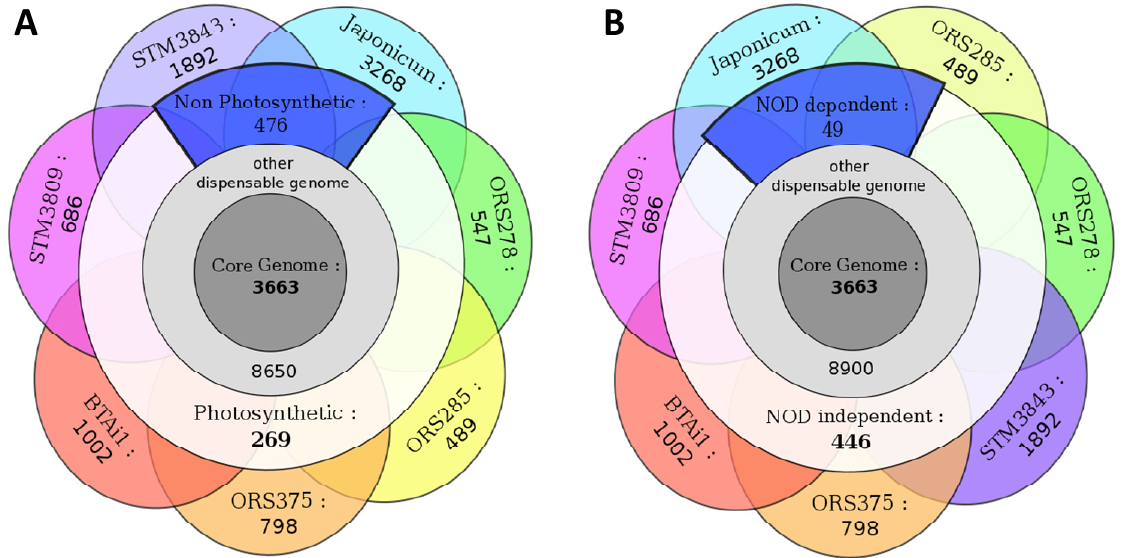
Figure 6. Phyloprofile exploration of genomes according to photosynthetic ( A ) and nodulation ( B )